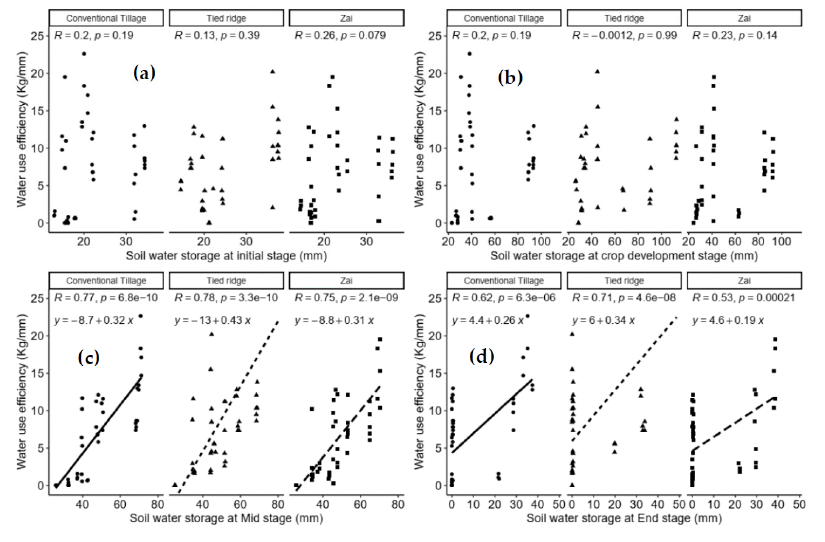
Figure 8. Effect of soil water storage on water use efficiency during maize growth stages at ( a ) crop establishment, ( b ) active vegetative growth and tasseling phases, ( c ) silking and grain filling phases, and ( d ) the crop maturity phase.